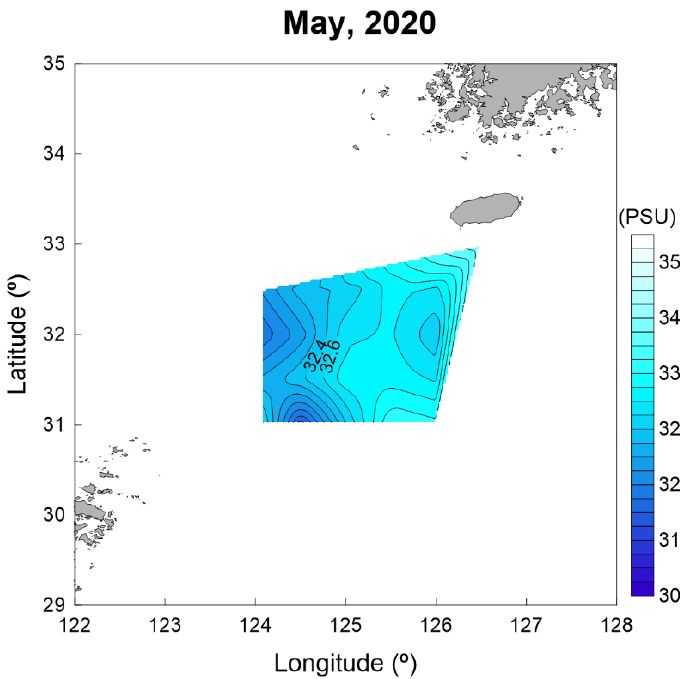
Figure 8. Distribution of salinity in the major swimming layers in the East China Sea.